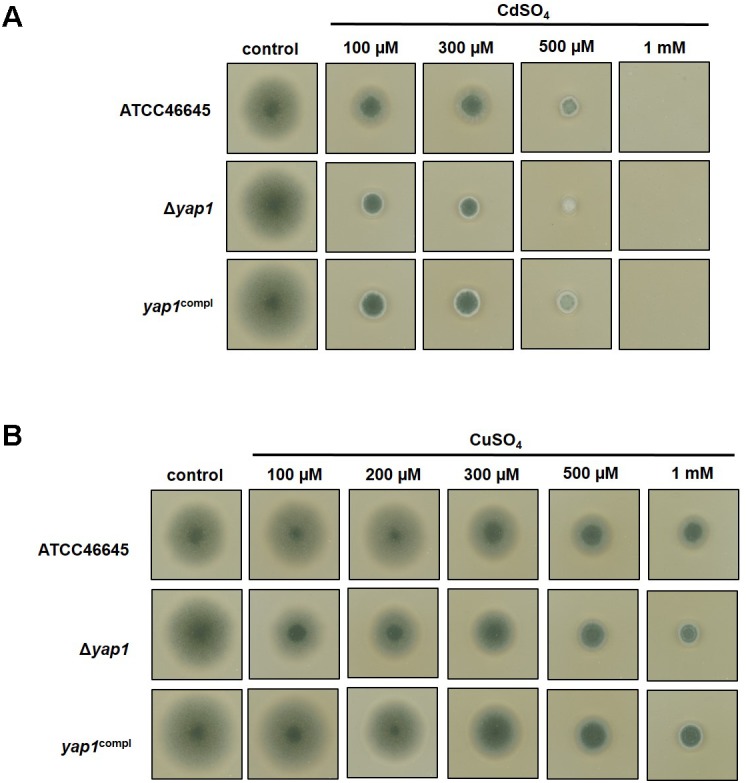
Growth of Δyap1 strain of A. fumigatus on copper and cadmium containing plates. The growth of the Δyap1 strain was followed in the presence of increasing concentrations of CdSO4 (in a range of 100 μM to 5 mM) and CuSO4 (ranging from 100 μM to 1 mM) in comparison to yap1compl strain and the WT ATC45546. (A) Cadmium ions have a pronounced negative effect on the growth of the Δyap1 strain even at lower concentrations compared to the normal growth conditions (unsupplemented, control plates), whereas the same concentration of cadmium ions have less toxic effect on the WT. (B) The presence of increased concentrations of copper ions reduce the growth of the Δyap1 strain compared to WT.